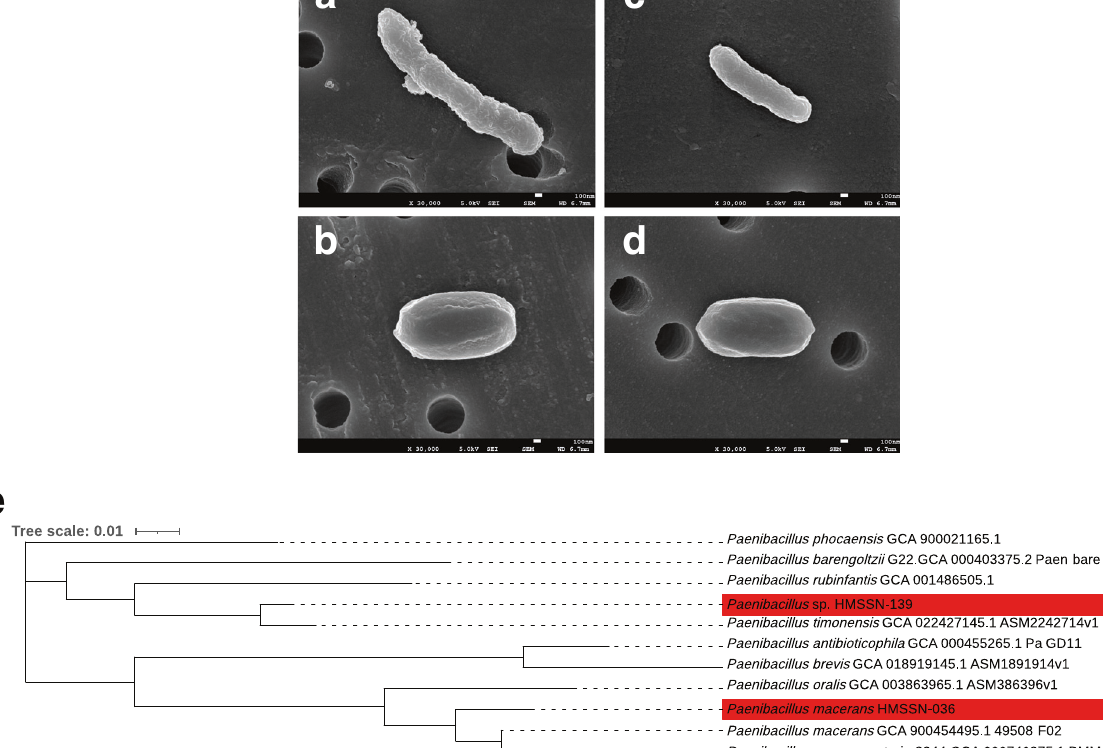
Fig. 6 Electron micrographs and phylogenetic relationships of isolated Paenibacillus strains in this study. a Scanning electron microscopy image of vegetative type Paenibacillus macerans HMSSN-036 stain. b Scanning electron microscopy image of spore type Paenibacillus macerans HMSSN-036 stain. c Scanning electron microscopy image of vegetative type Paenibacillus sp. HMSSN-139 stain. d Scanning electron microscopy image of spore type Paenibacillus sp. HMSSN-139 strain. e Whole-genome phylogenetic analysis of isolated Paenibacillus strains was performed. A phylogenetic tree was constructed by the neighbor-joining method. The isolated Paenibacillus strains are marked in red. Table 1. Functional genes identi fi ed based on the genomic data of Paenibacillus sp. isolated from the thermophile-fermented compost (see Figs. S13 and S14 and Tables S7 – S10 in the supplementary